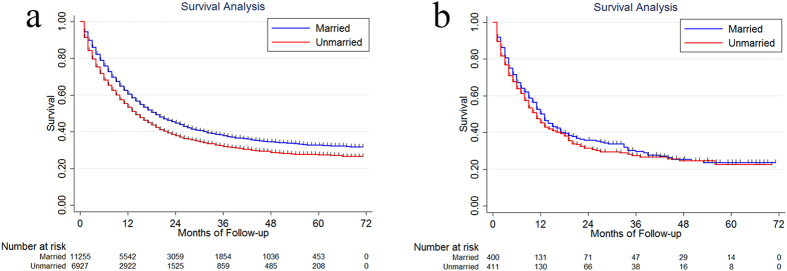
The survival difference between married and unmarried patients in insured (a) and uninsured patients (b).